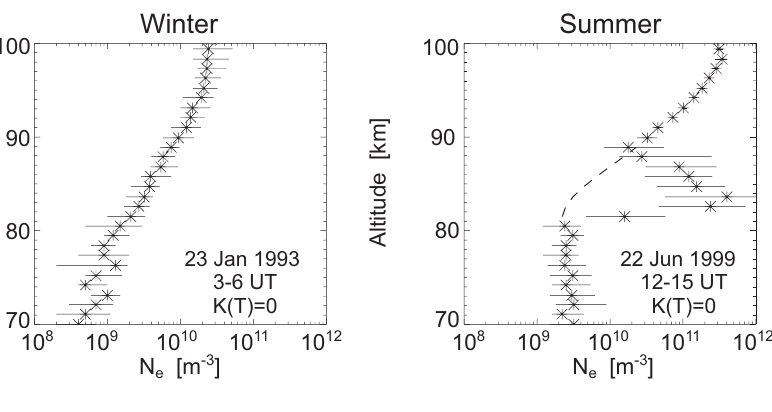
Fig. 1. Sample 3-h median profiles from EISCAT CP-6 measurements for typical winter (night) and summer (day) conditions. In the summer profile the interpolation of the electron density during PMSE events is demonstrated.